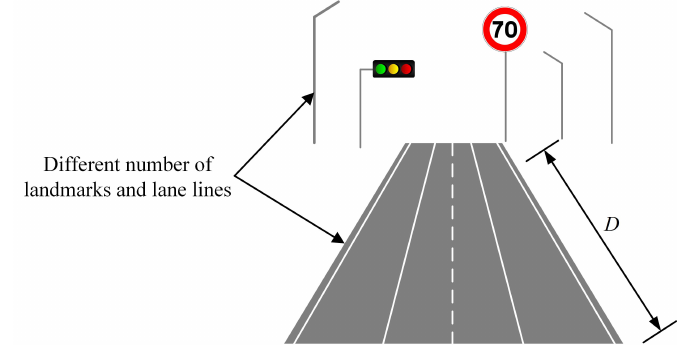
Figure 9. Illustration of scenario